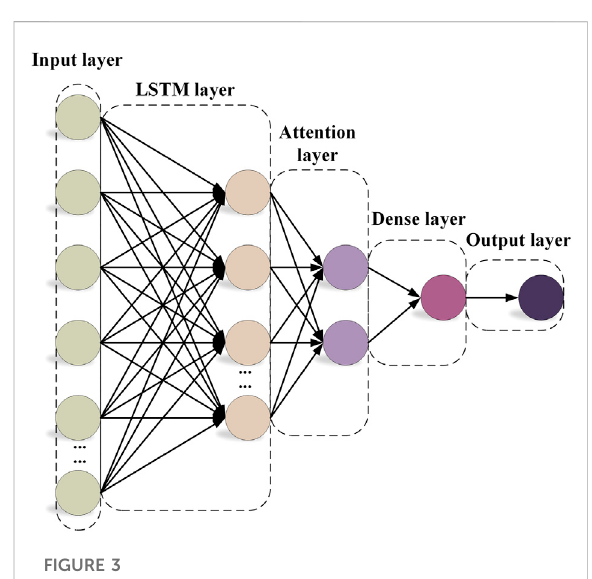
FIGURE 3 The overall structure of SOH prediction